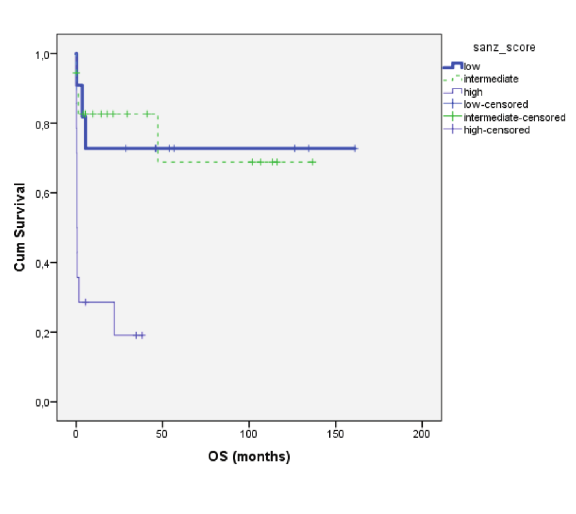
Figure 2: Overall survival of the patients according to Sanz score